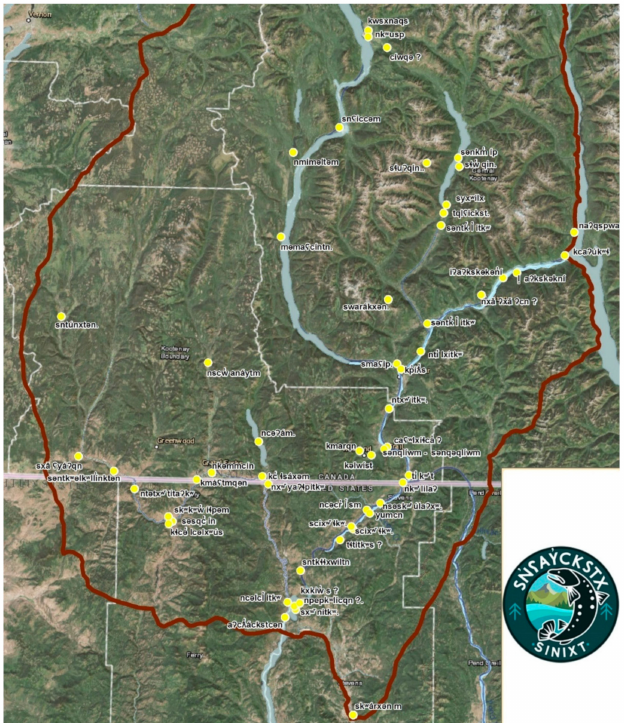
Figure 6. Detail from the s´n Q a ý ckstx (Sinixt) place-names map, currently under construction by the Tribe in collaboration with the Colville Confederated Tribes. This detail shows the Tribe’s territory and selected place names from today’s Nakusp north into British Columbia, and south to Kettle Falls in Washington State [63] (also See Supplementary Materials). Reprinted with permission from The Confederated Tribes of the Colville Reservation. Colville Confederated Tribes. 2021.